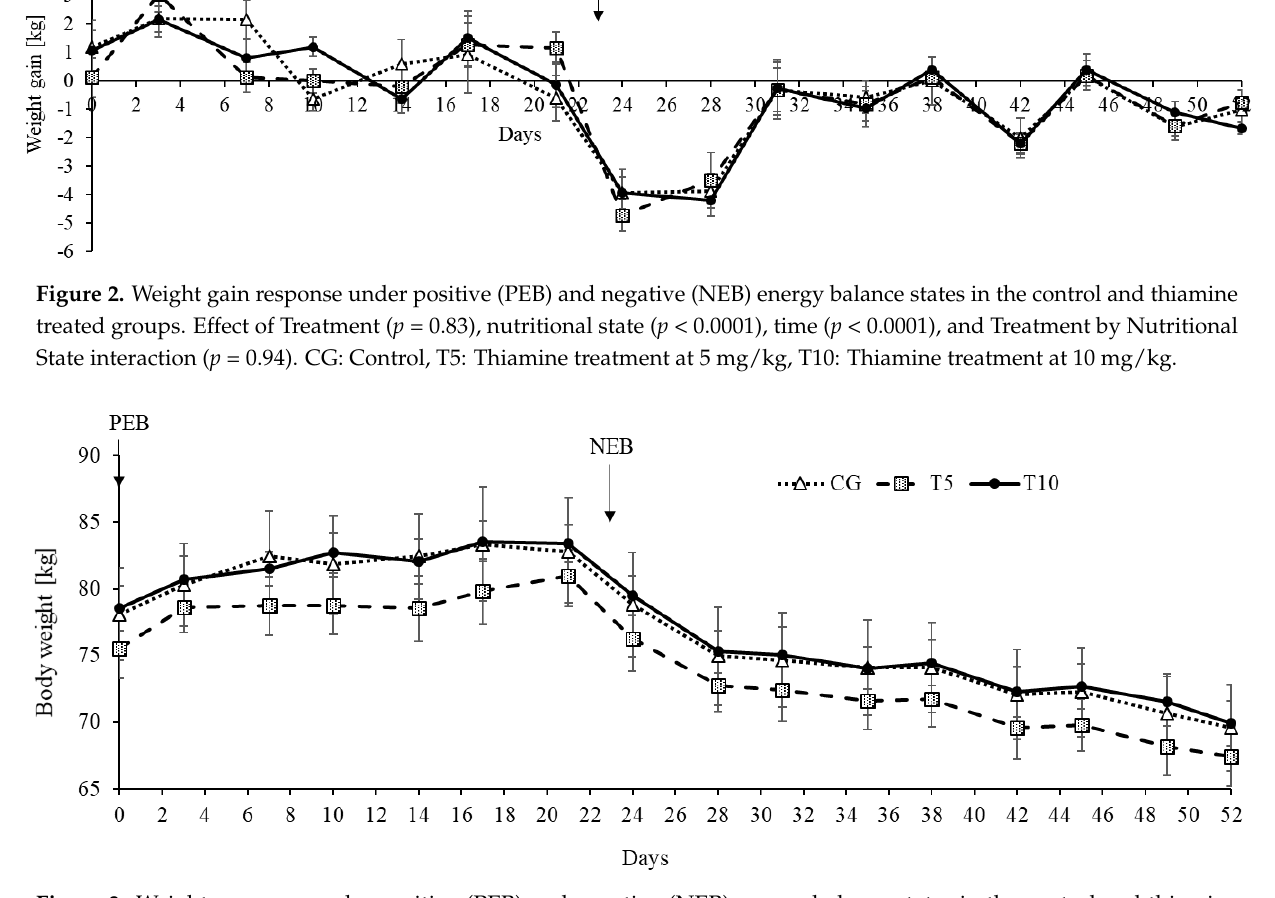
Figure 3. Weight response under positive (PEB) and negative (NEB) energy balance states in the control and thiamine treated groups. Effect of Treatment ( p = 0.67), Nutritional State ( p < 0.0001), time ( p < 0.0001), and Treatment by Nutritional State interaction ( p = 0.33). CG: Control, T5: Thiamine treatment at 5 mg/kg, T10: Thiamine treatment at 10 mg/kg.